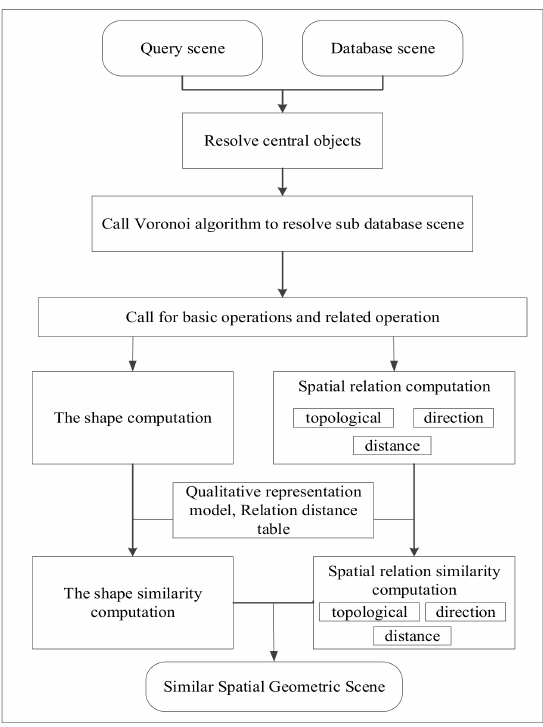
Figure 1. Spatial geometric similarity retrieval